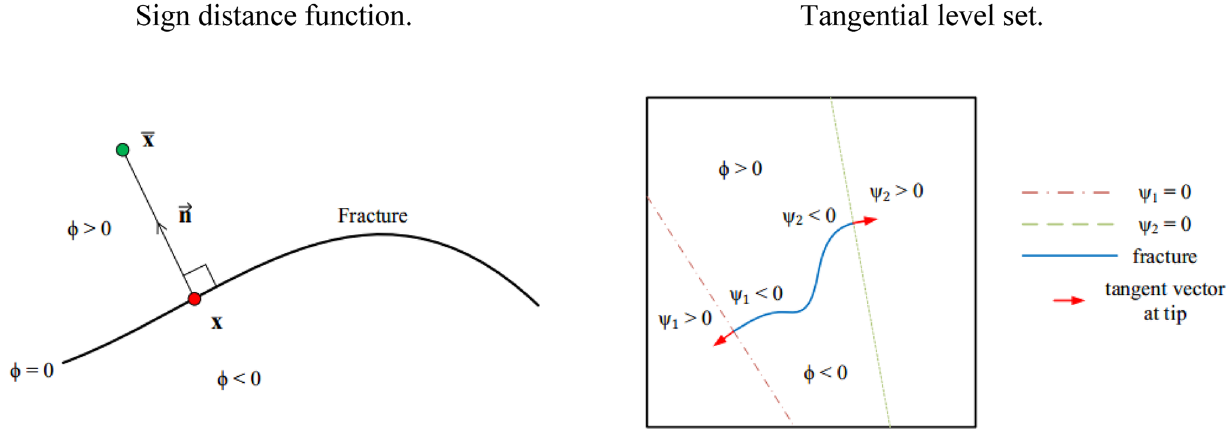
Fig. 4 LSF function parameter visualization (Youn